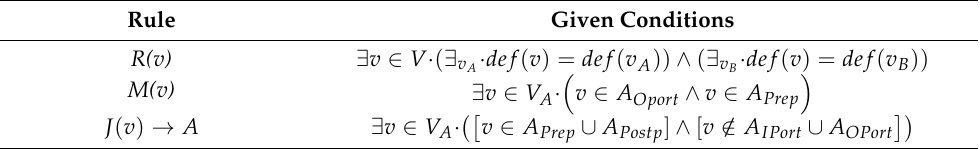
Table 3. Variable